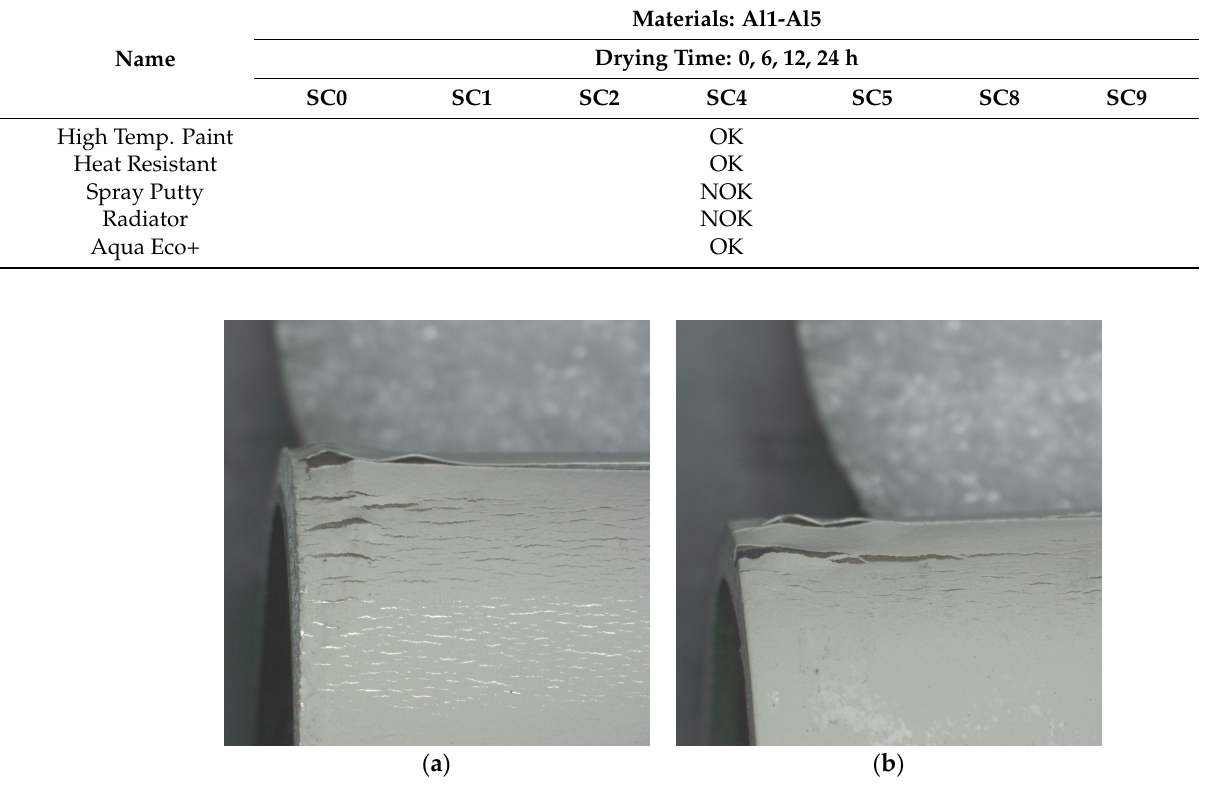
Figure 3. Results of a successful bending test. ( a ) adequate result achieved by P3 paint; ( b ) adequate result achieved by P9 paint.